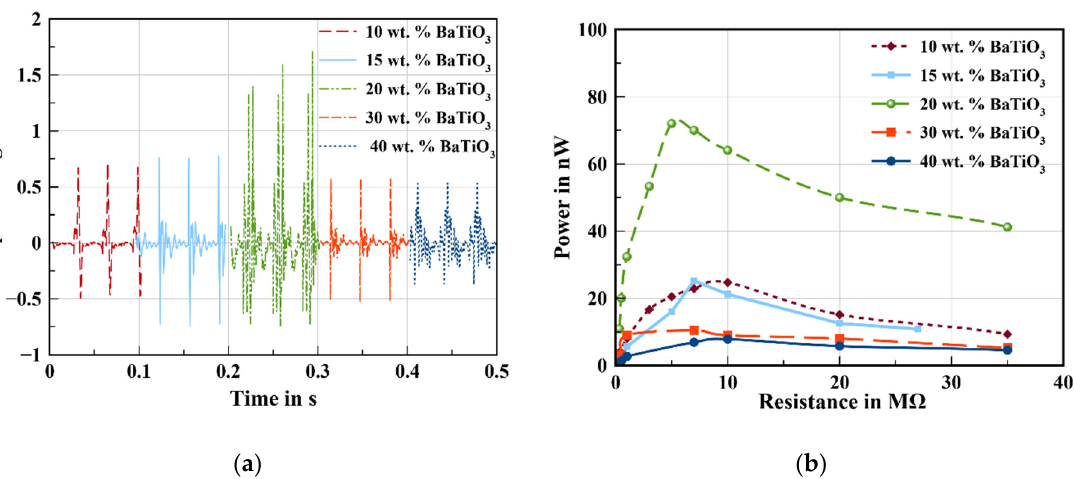
Figure 2. Performance of nanogenerators depending on the concentration of BaTiO 3 : ( a ) output voltage and ( b ) output power.